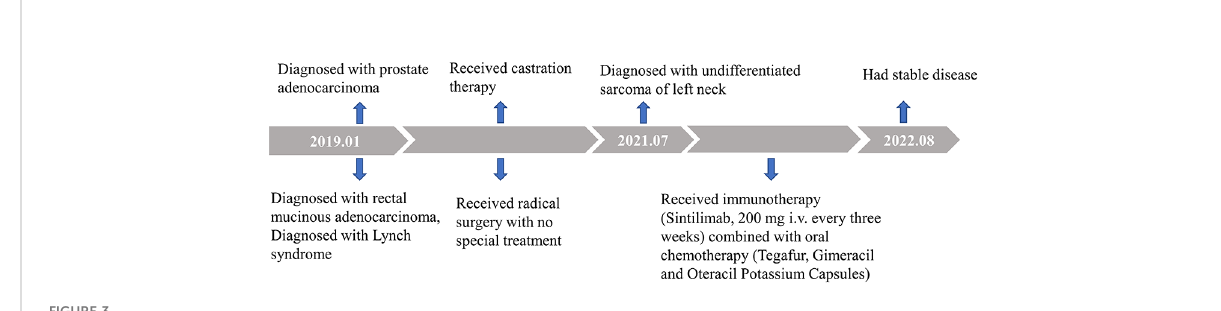
FIGURE 3 Timeline scheme of the major clinical event of the